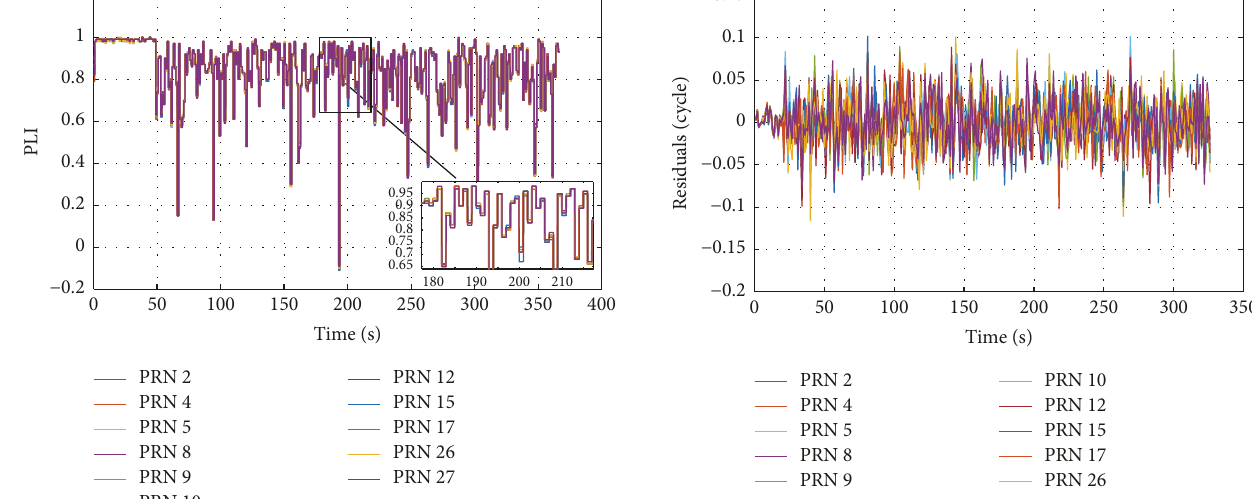
Figure 6: PLI for different satellites with 1Hz bandwidth.